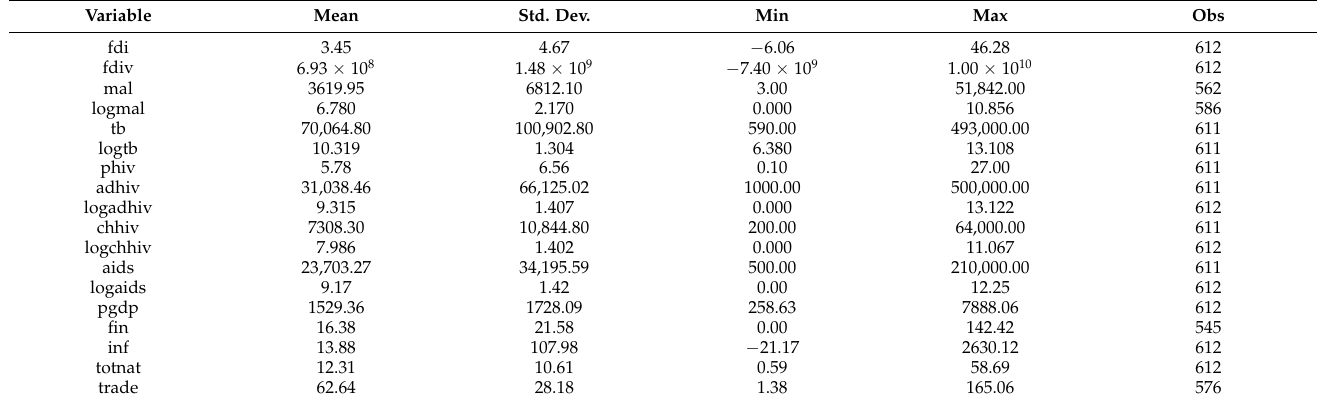
Table 2. Descriptive statistics of all variables of interest.